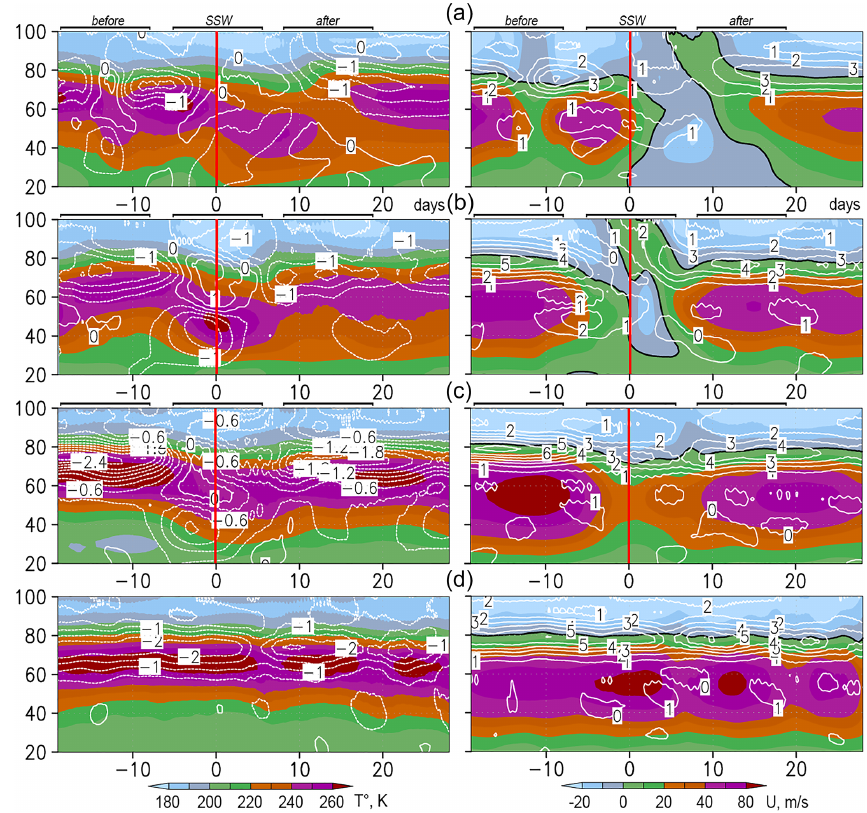
Figure 1. Examples of simulated zonal-mean temperature in K averaged over a latitudinal band of 82–87 ◦ N (shaded left) and zonal- mean zonal wind in ms − 1 at 62 ◦ N (shaded right) for MUAM runs with different phases of stratospheric vacillations. Panels (a) – (d) show, respectively, major SSW, HSW, minor SSW and a MUAM run without stratospheric warming. Contours show residual vertical velocity in cms − 1 (left) and residual meridional velocity in ms − 1 (right) at respective latitudes (dashed contours refer to negative values). Zero days correspond to the respective SSW onset dates. Horizontal lines above the plots show time intervals before, during and after